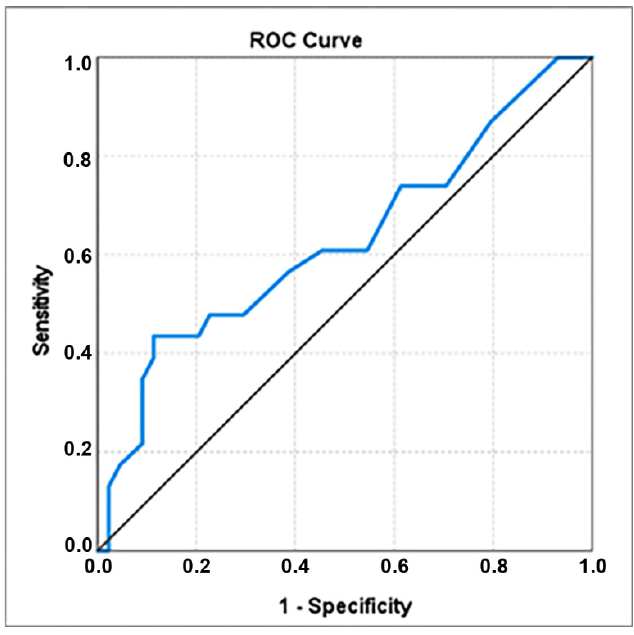
Figure 1. ROC curve for cervical length. Table 3. Univariate and ROC analysis of continuous prognostic factors.